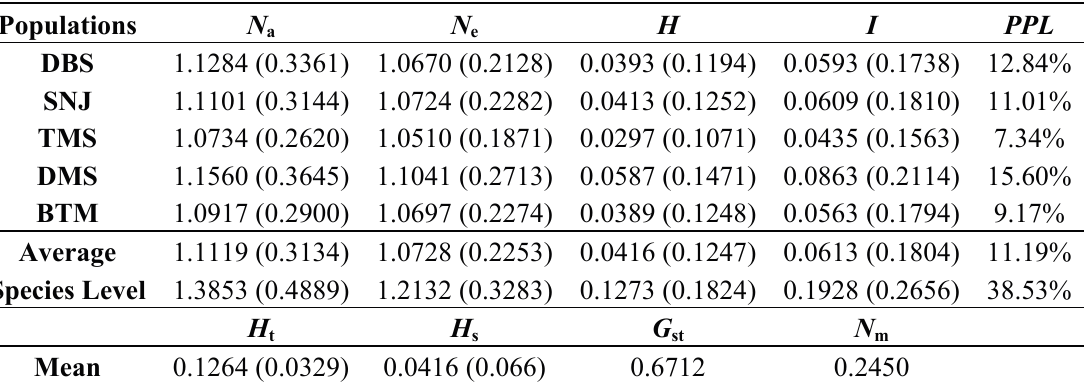
Table 1. Genetic diversity of Cypripedium japonicum populations.